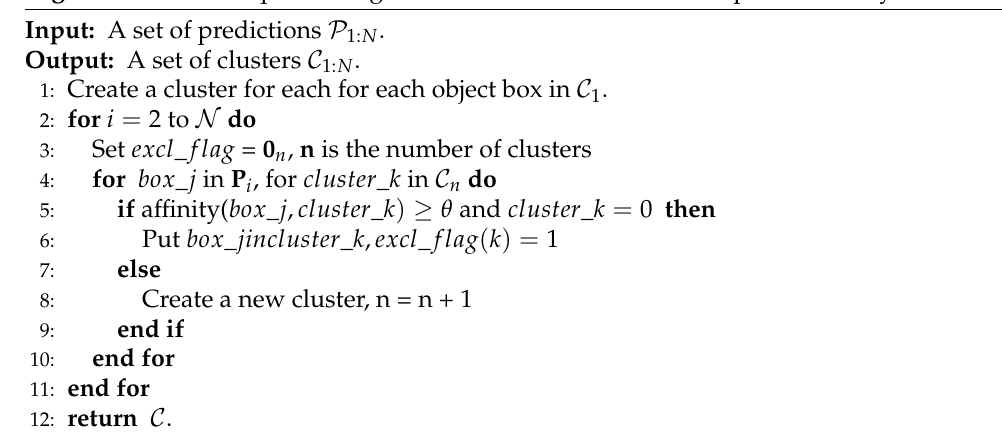
Algorithm 2 Basic sequential algorithmic scheme with intra-sample